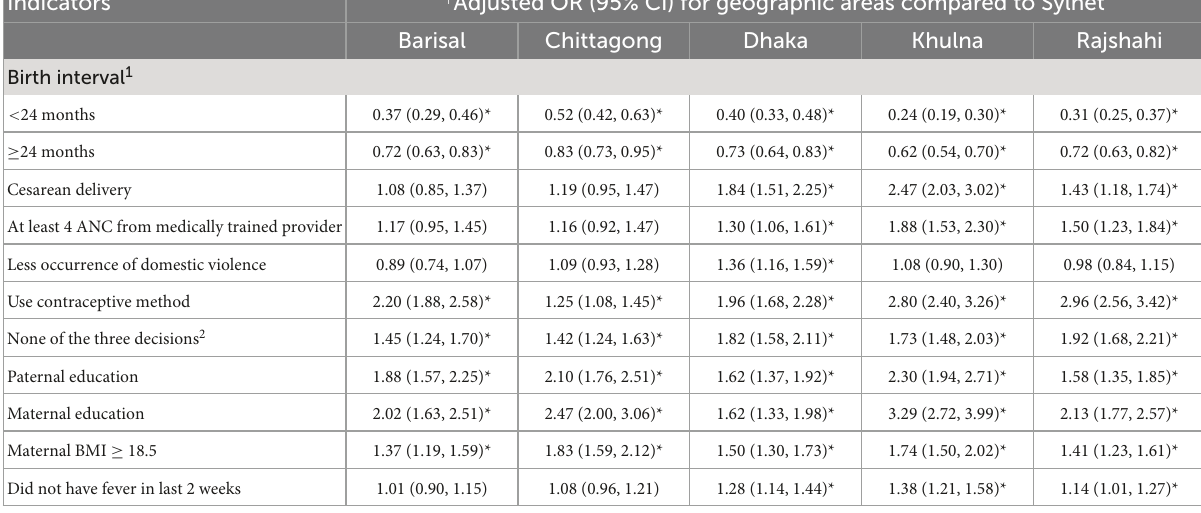
TABLE 3 Comparison of the predictors of malnutrition among the geographical regions.